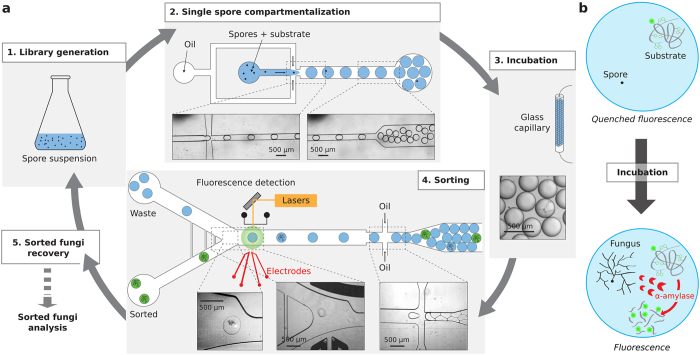
Droplet-based microfluidics screening platform.(a) Schematic of the system. 1. Generation of a whole-genome mutated fungi library. 2. The spores are compartmentalized in ~10 nl droplets with a fluorogenic enzyme substrate using an appropriate spore to droplet ratio allowing compartmentalization of single spores. 3. The emulsion is incubated 24 h off-chip at 30 °C in a glass capillary to allow fungi development, enzyme secretion and substrate digestion within the droplets. 4. Droplets are reloaded into a sorting device and sorted based on enzymatic activity according to fluorescence intensity. 5. Fungi are recovered from sorted droplets and either characterized or subjected to another round of mutagenesis and/or selection. (b) α-amylase fluorogenic assay. The substrate consists of a starch backbone with multiple quenched BODIPY®FL fluorophores. α-amylase hydrolyzes the starch backbone to unquench the fluorophores and induce fluorescence.